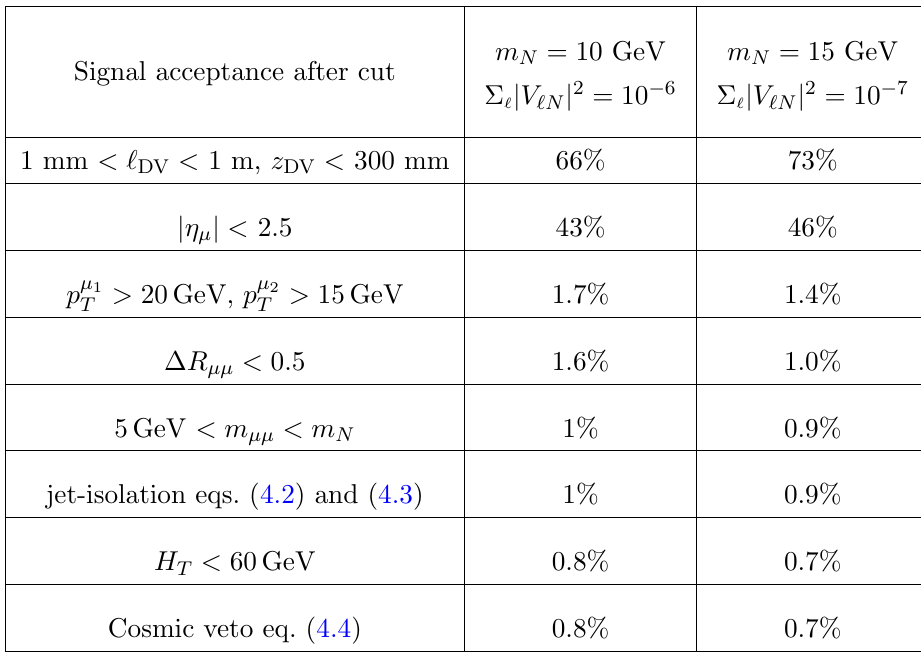
Table 1 . Cut (cid:13)ow for two HNL benchmark scenarios. Each row shows the acceptances with respect to the initial cross sections. We apply the cuts sequentially from top to down.